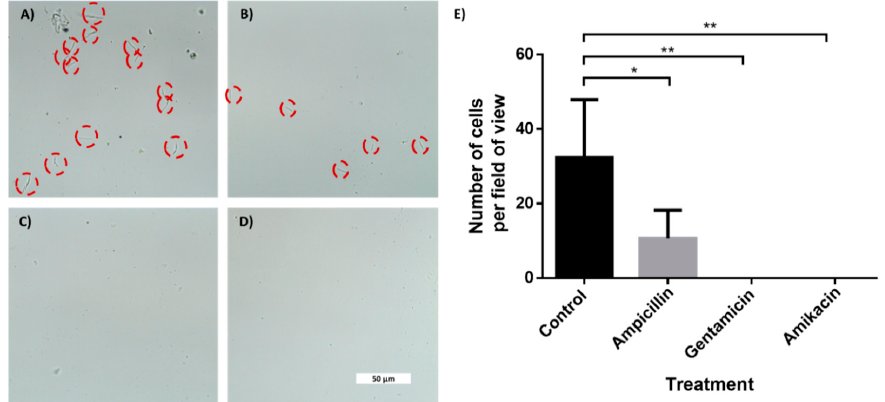
Figure 5. In-chip antibiotic sensitivity testing of an E. coli-spiked sample. Brightfield microscopy photos of E. coli cells taken with 60× objective after 2 h of incubation. The cells were incubated inside microchannels with an entrance coated with a superhydrophobic coating. ( A ) Control channel. Channel with drop-dried ( B ) ampicillin, ( C ) gentamicin and ( D ) amikacin. ( E ) Manual cells count per field of view (690 µm × 300 µm) using a 20× magnification. n = 3. Error bars indicate standard deviation (SD). * P ≤ 0.05, ** P ≤ 0.01.